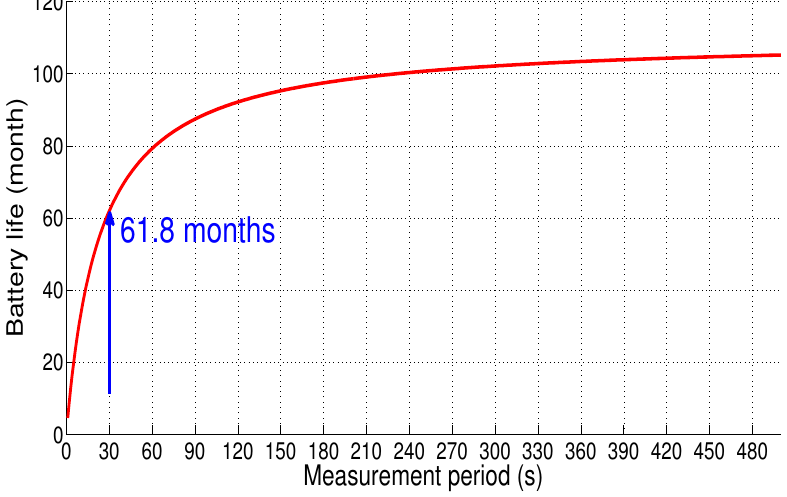
Figure 16. Sensor node autonomy: Scenario